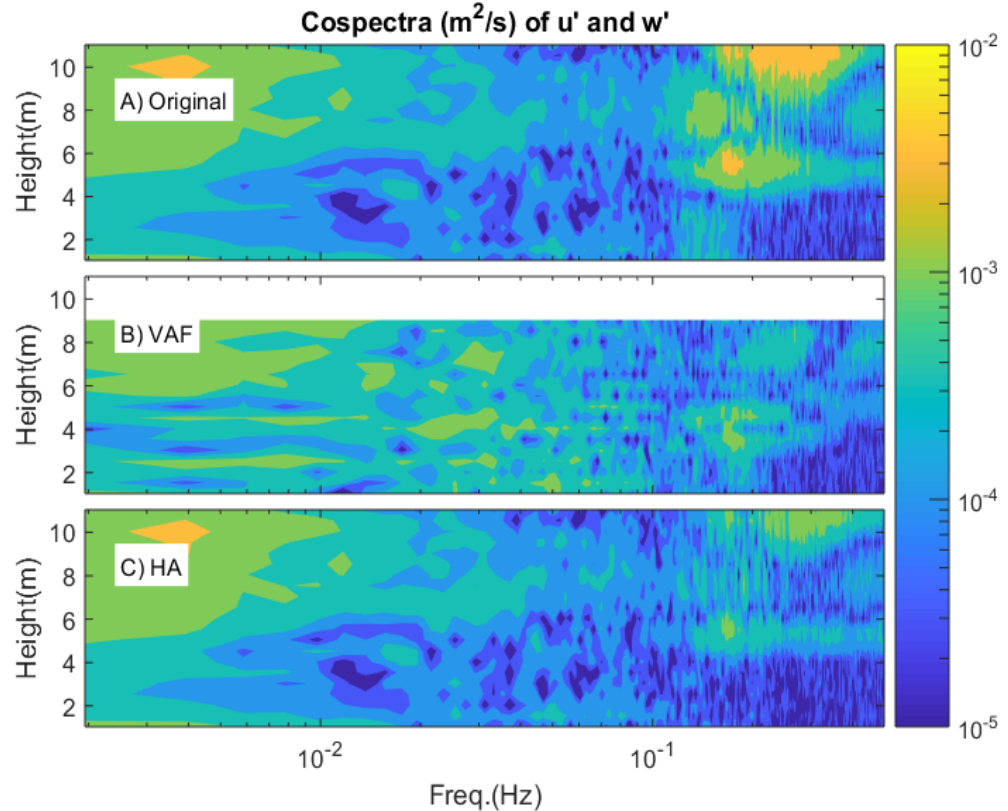
Figure 6. Time-averaged cospectra (Co u (cid:48) w (cid:48) , m 2 / s) of u (cid:48) and w (cid:48) ( A ) original; ( B ) corrected by VAF method; and ( C ) corrected by HA method.